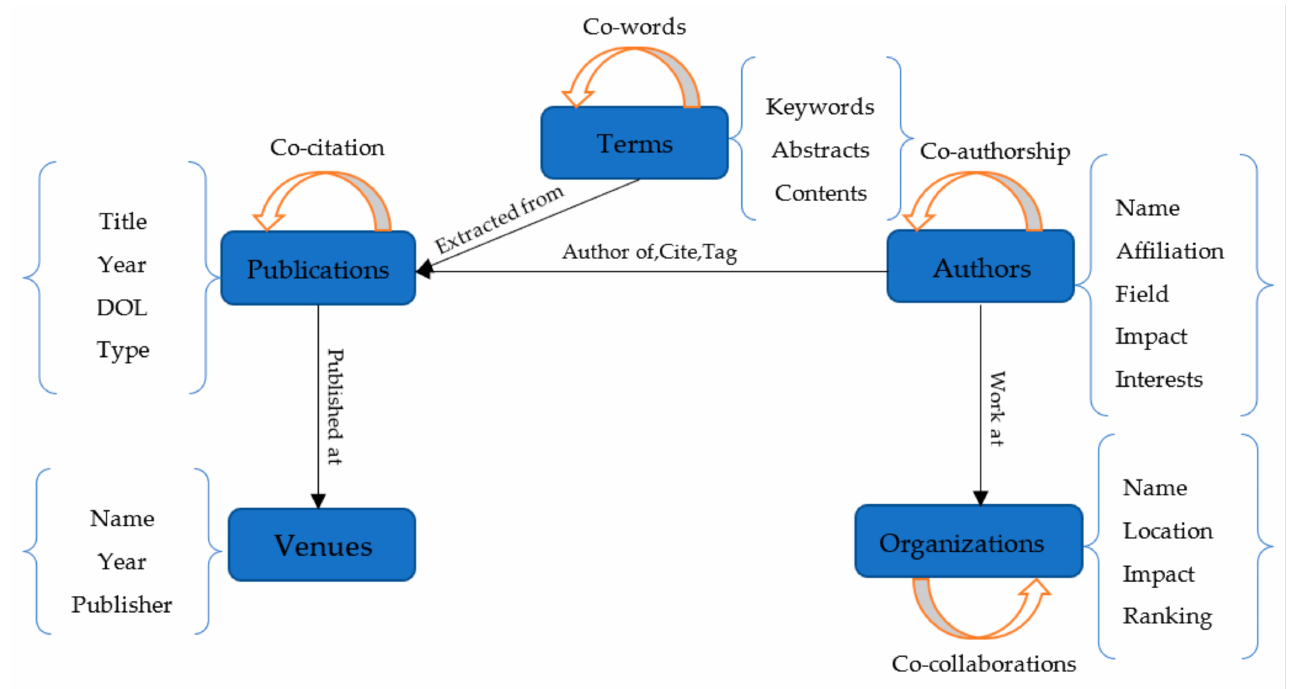
Figure 1. Academic social networks’ entities